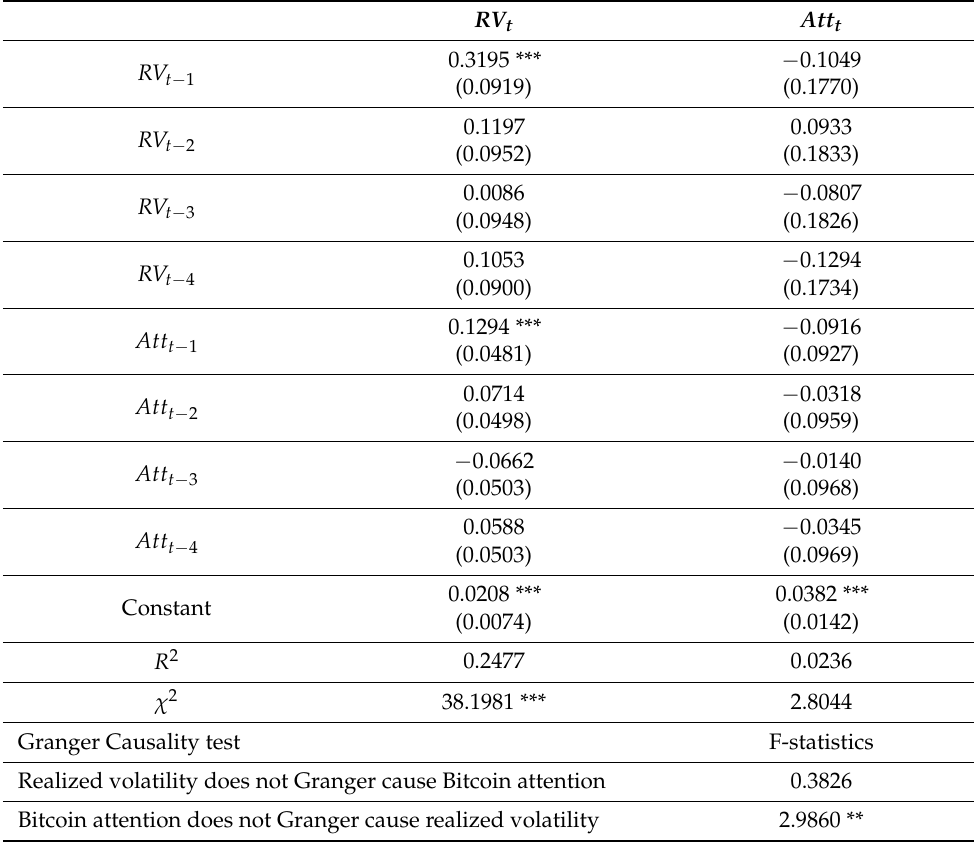
Table 15. VAR estimation between Bitcoin attention and realized